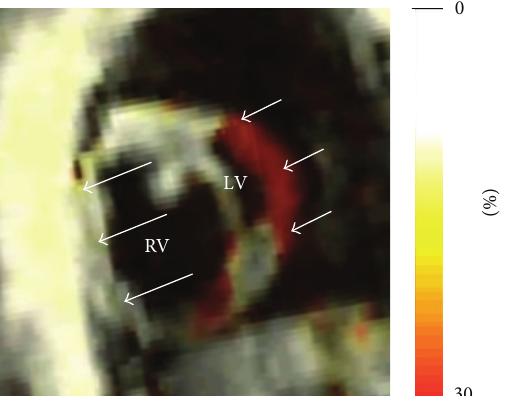
Figure 5: Short-axis strain-encoding (SENC) image showing color-coded longitudinal strain at end systole. Although the left ventricle (LV) is normally contracting (appears red, short arrows), the right ventricle (RV) shows negligible contraction (appears white, long arrows).